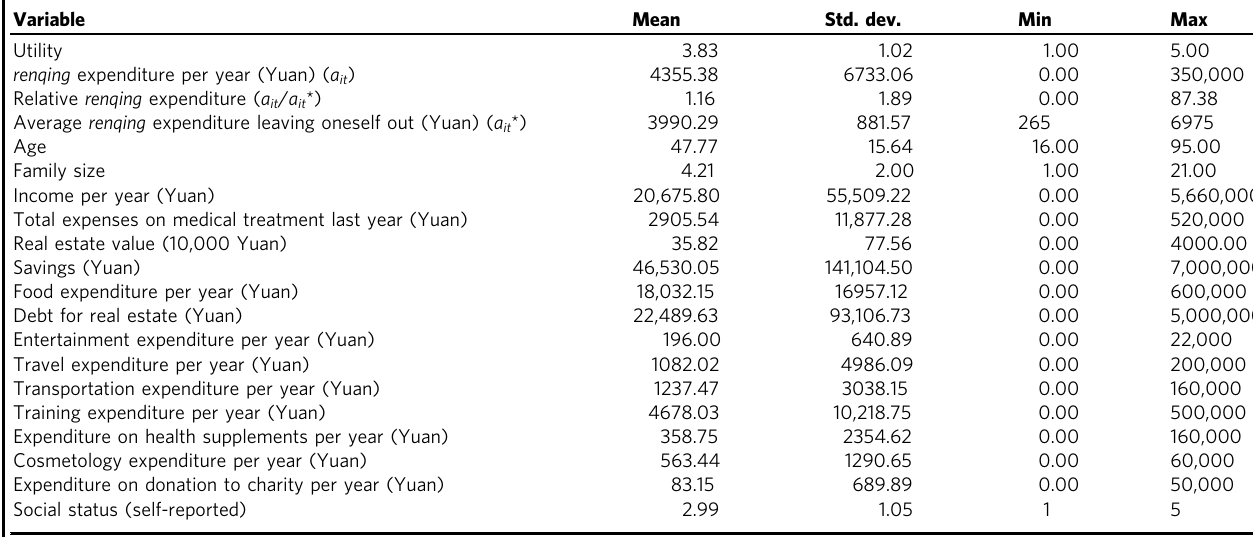
Table 1 Summary statistics of variables for each observation.